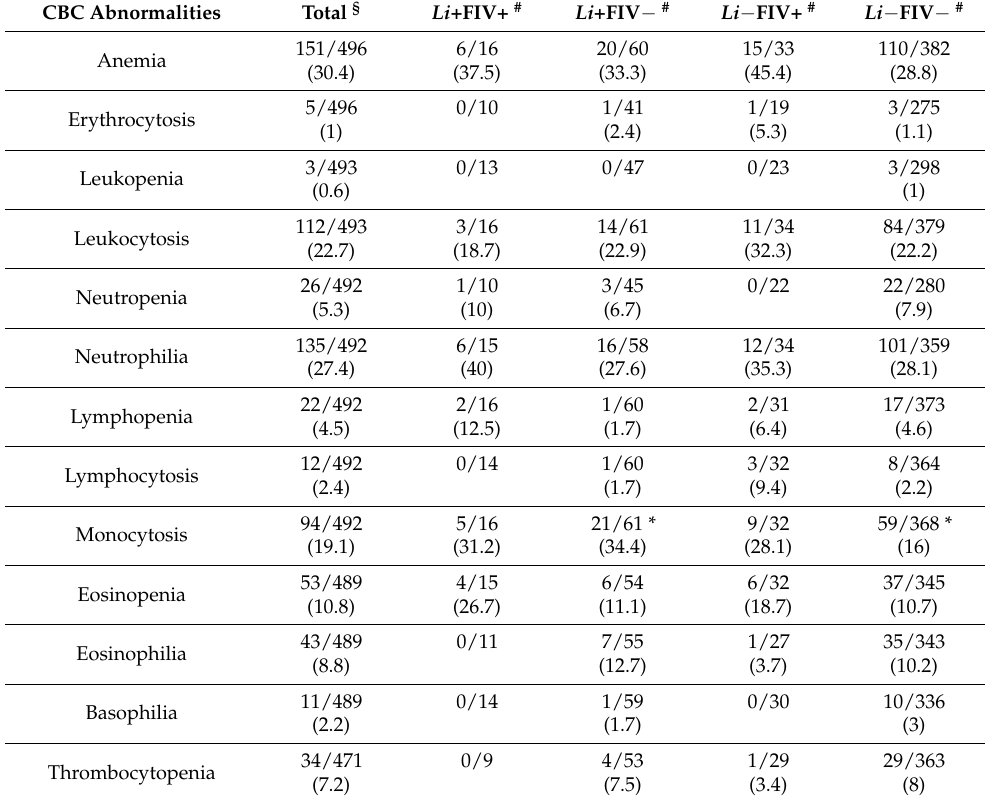
Table 8. Prevalence of complete blood count (CBC) abnormalities ( n (%)) in total enrolled cats (total) and of cats classified according to their infection pattern ( Li +FIV+; Li +FIV − ; Li − FIV+; Li − FIV − ). CBC